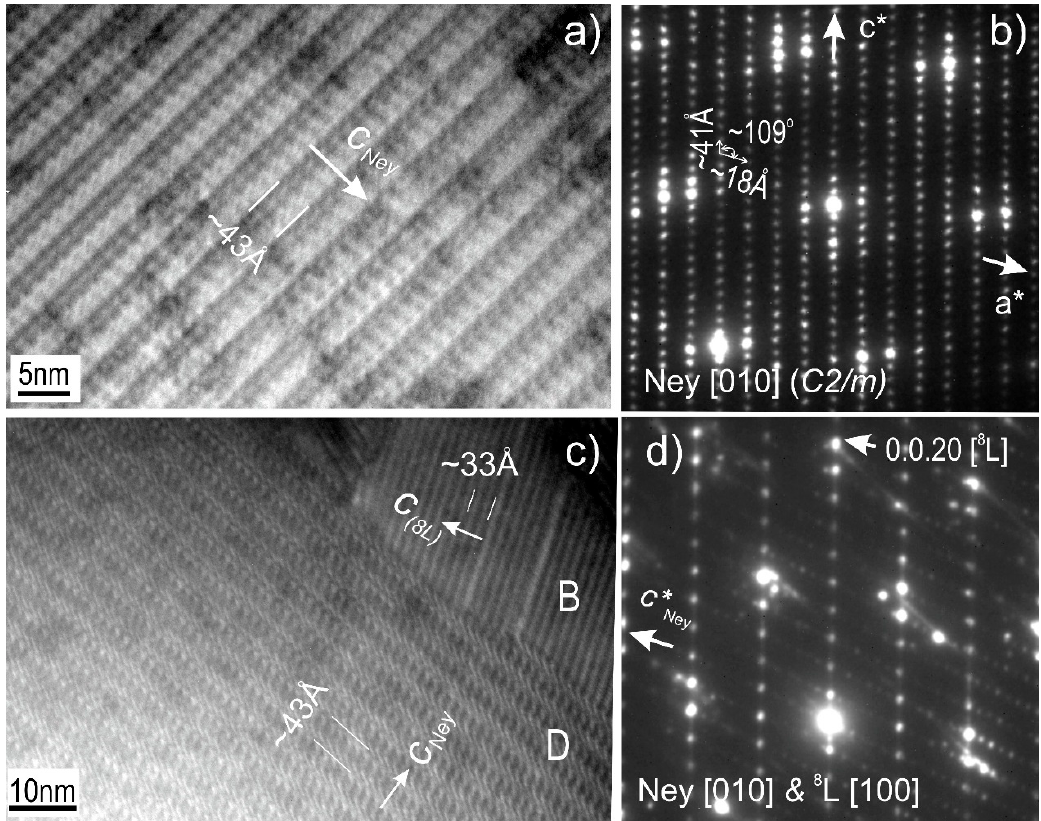
Figure 8. BF HR-TEM images and SAEDs (on zone axes as marked) showing details of Pb-Bi sulphosalt (D) ( a , b ) indexed as neyite (Ney); and relationships with Pb-Bi-sulphosalt (B) identified as 8 L ( c , d ); Note the step-wise offsets at the contact between the two sulphosalts ( c ).